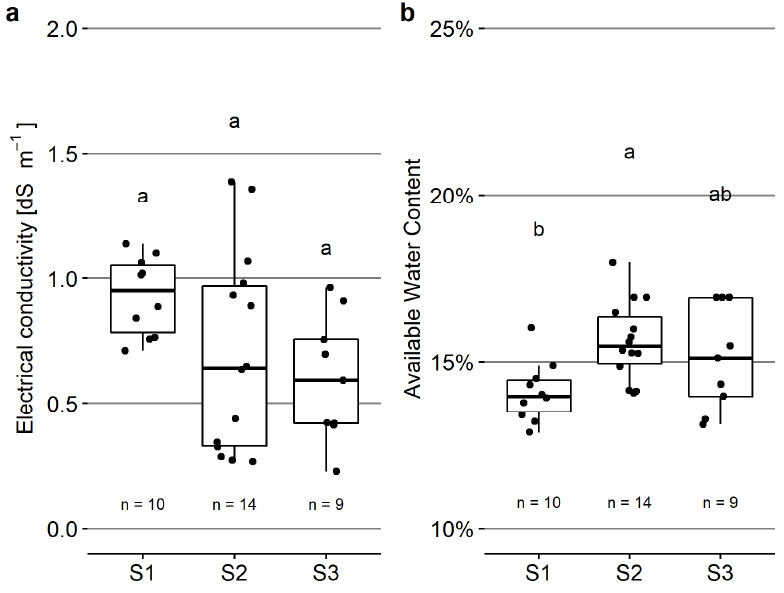
Figure 10. Distribution of ( a ) electrical conductivity [dS m − 1 ], and ( b ) AWC [%] in classes S1, S2 and S3.